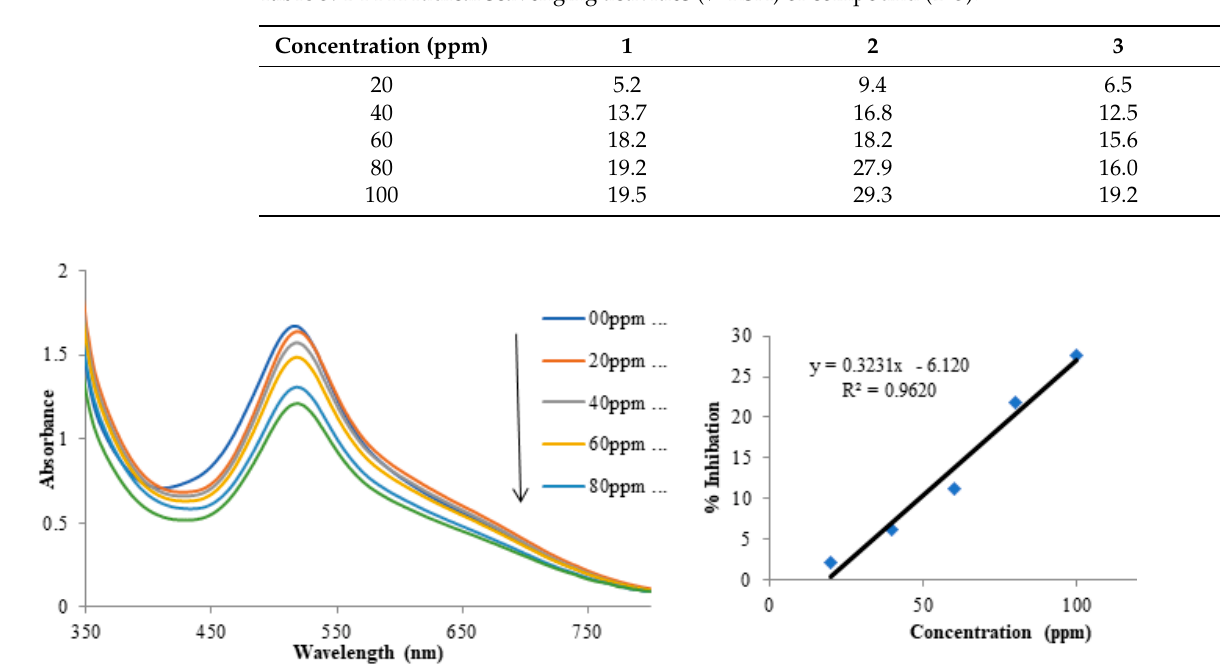
Figure 14. Absorption spectra of blank (DPPH, top) which alters by addition of compound 2 ( left ), graphical representation of % Inhibition versus concentration of compound 2 mixed with DPPH solution ( right ). Figure 15. Absorption spectra of compound 3 and pure DPPH, the maximum absorbance was ob- served for the later one ( left ) and % Inhibition versus concentration of compound 3 for radical scav- enging activity ( right ).